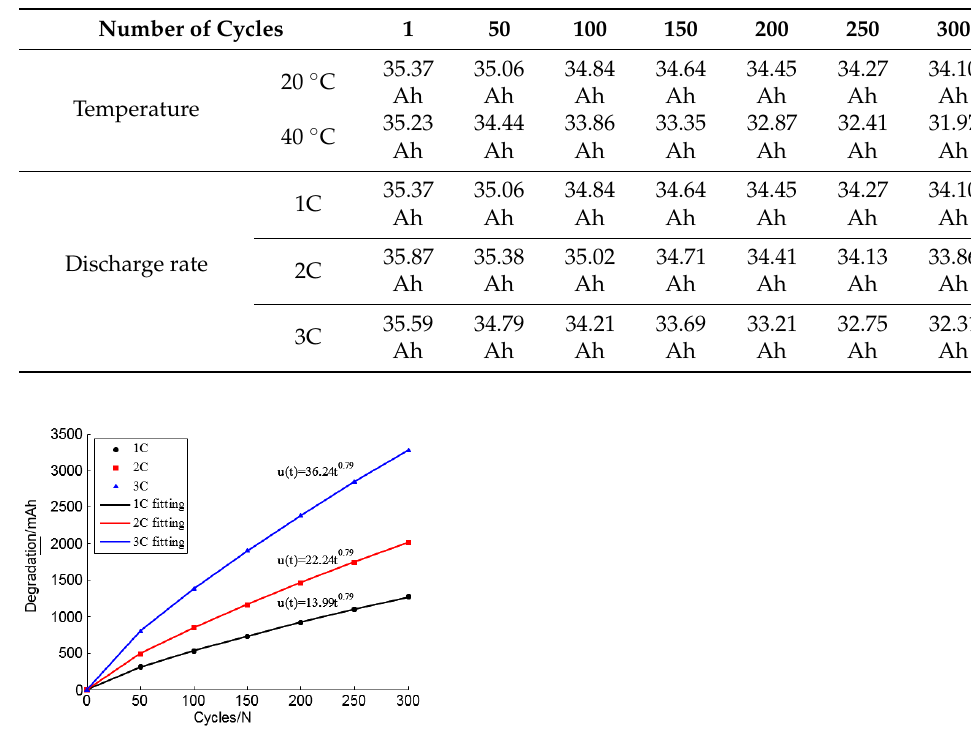
Figure 5. Capacity degradation curves at different discharge rates.